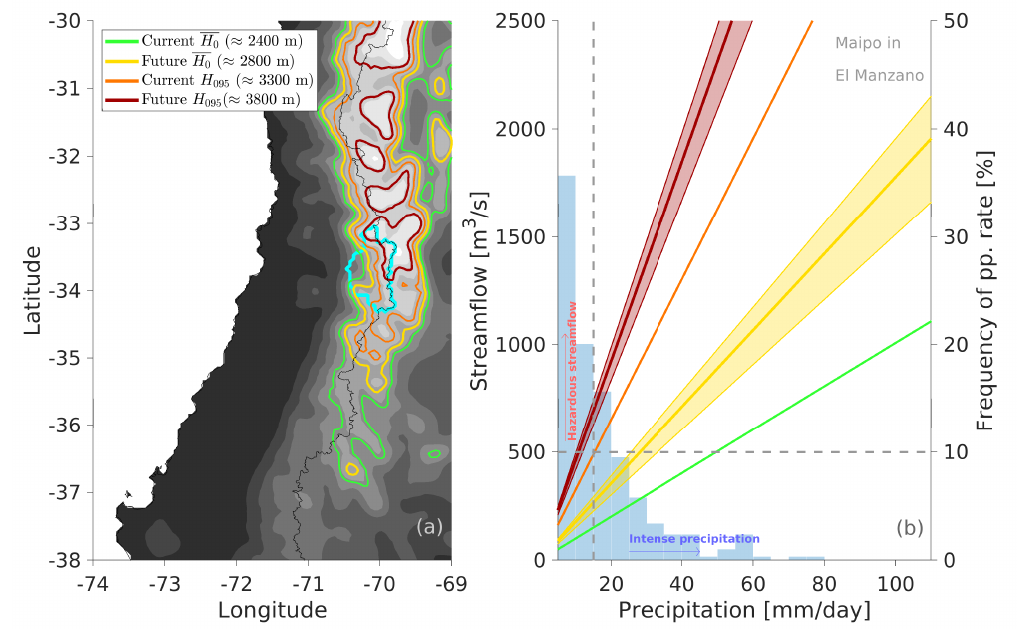
Figure 9. ( a ) Central Chile topography with present and future H 0 contours (mean and 95th percentile value). The upper Maipo river basin is delimited by the cyan line. ( b ) Estimated stream flow at the outlet of the upper Maipo river basin as a function of precipitation for different values of H 0 (mean and 95th percentile value) in present and end-of-the-century climate conditions (2071–2100 under RCP8.5). The histogram in the background shows the distribution of daily accumulated precipitation over 5 mm/day for station Quinta Normal in Santiago close to the outlet of the upper Maipo river